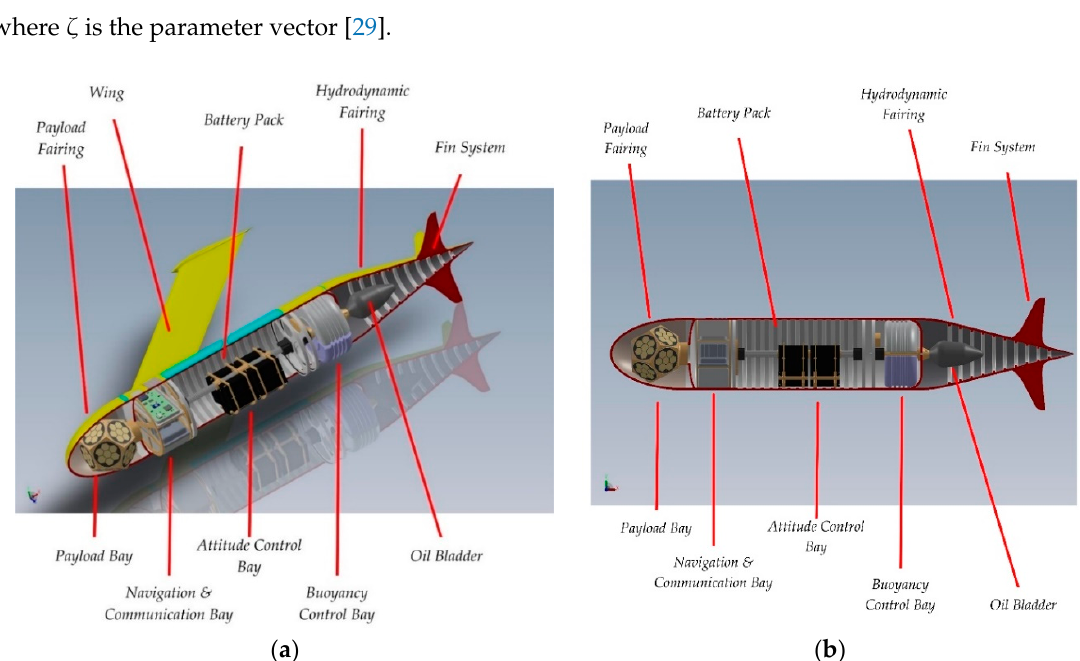
Figure 2. Underwater Glider Mk. III cutaway: ( a ) fuselage prospective section; ( b ) fuselage sagittal section.